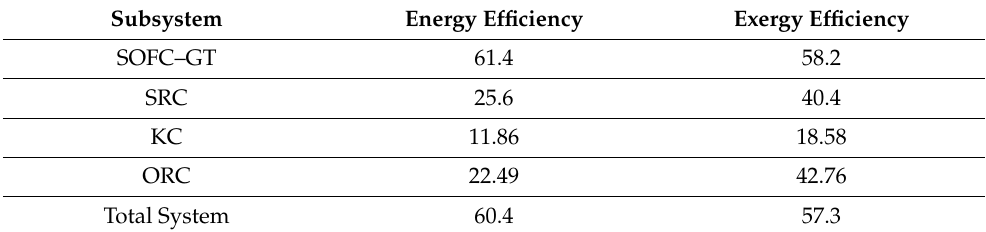
Figure 4. Heat exchanger network for the sequential optimization of the SOFC–SRC–KC-ORC system. ( a ) Heat load; ( b ) Driving force plot. Table 10. Energy and exergy efficiencies of the